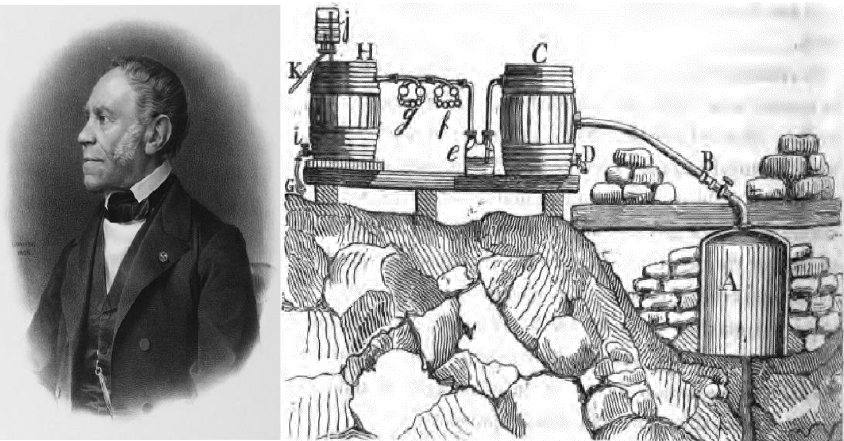
Figure 8. Francois Anselme Payen and his equipment that was used to perform the first analysis of geothermal gases.